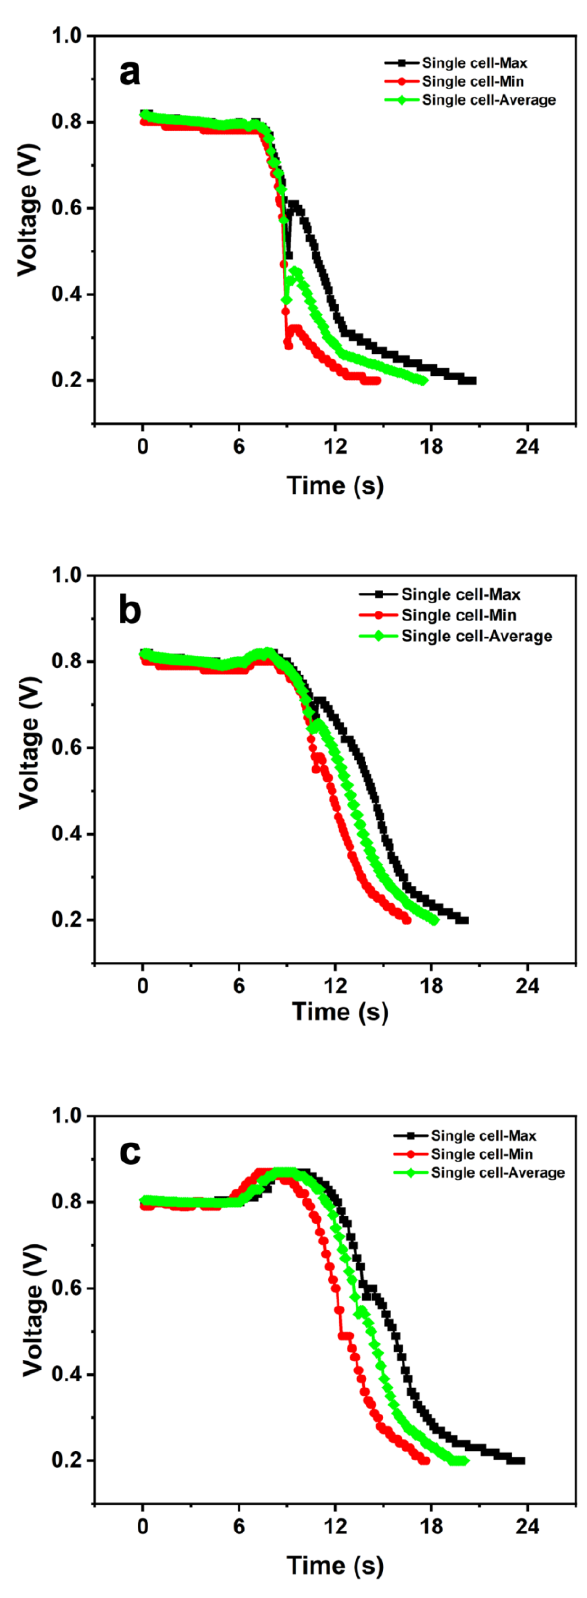
Figure 6. The consistency of the PEMFC stack at different discharge current drop rates. ( a ) 5 A/s, ( b ) 7 A/s, ( c ) 10 A/s.